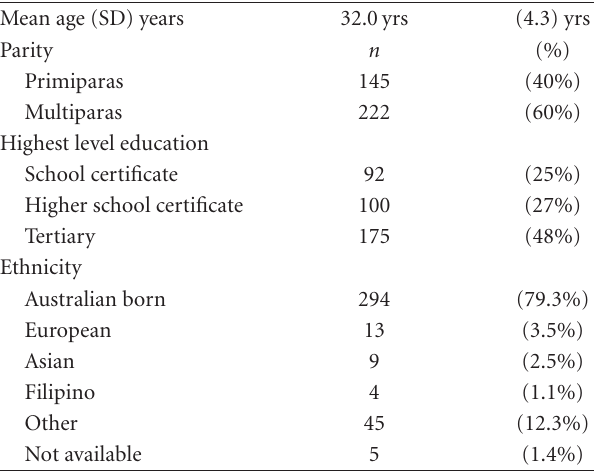
Table 1: Summary statistics for the 367 patients